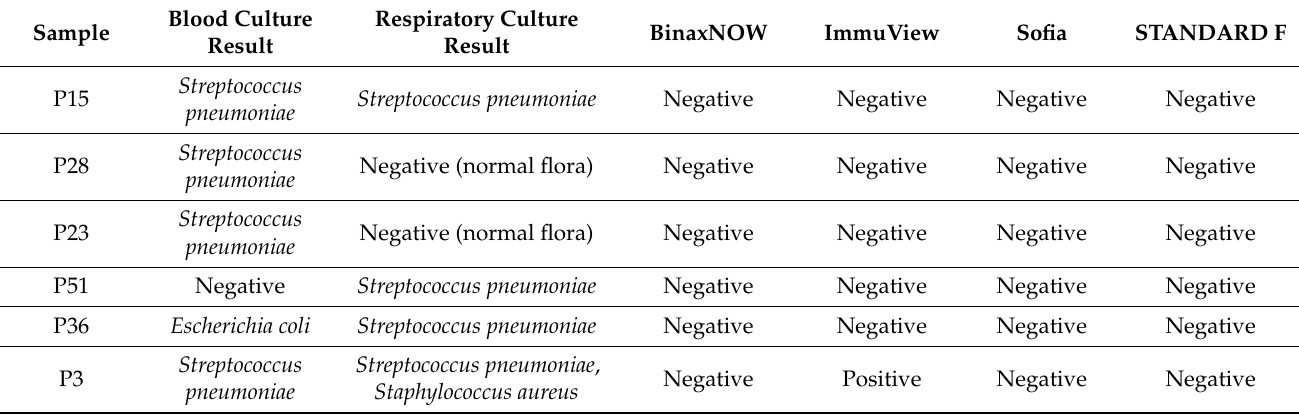
Table 3. False negative and discordant test results by four Streptococcus pneumoniae urine antigen tests in 14 patients with pneumococcal infection. Sample